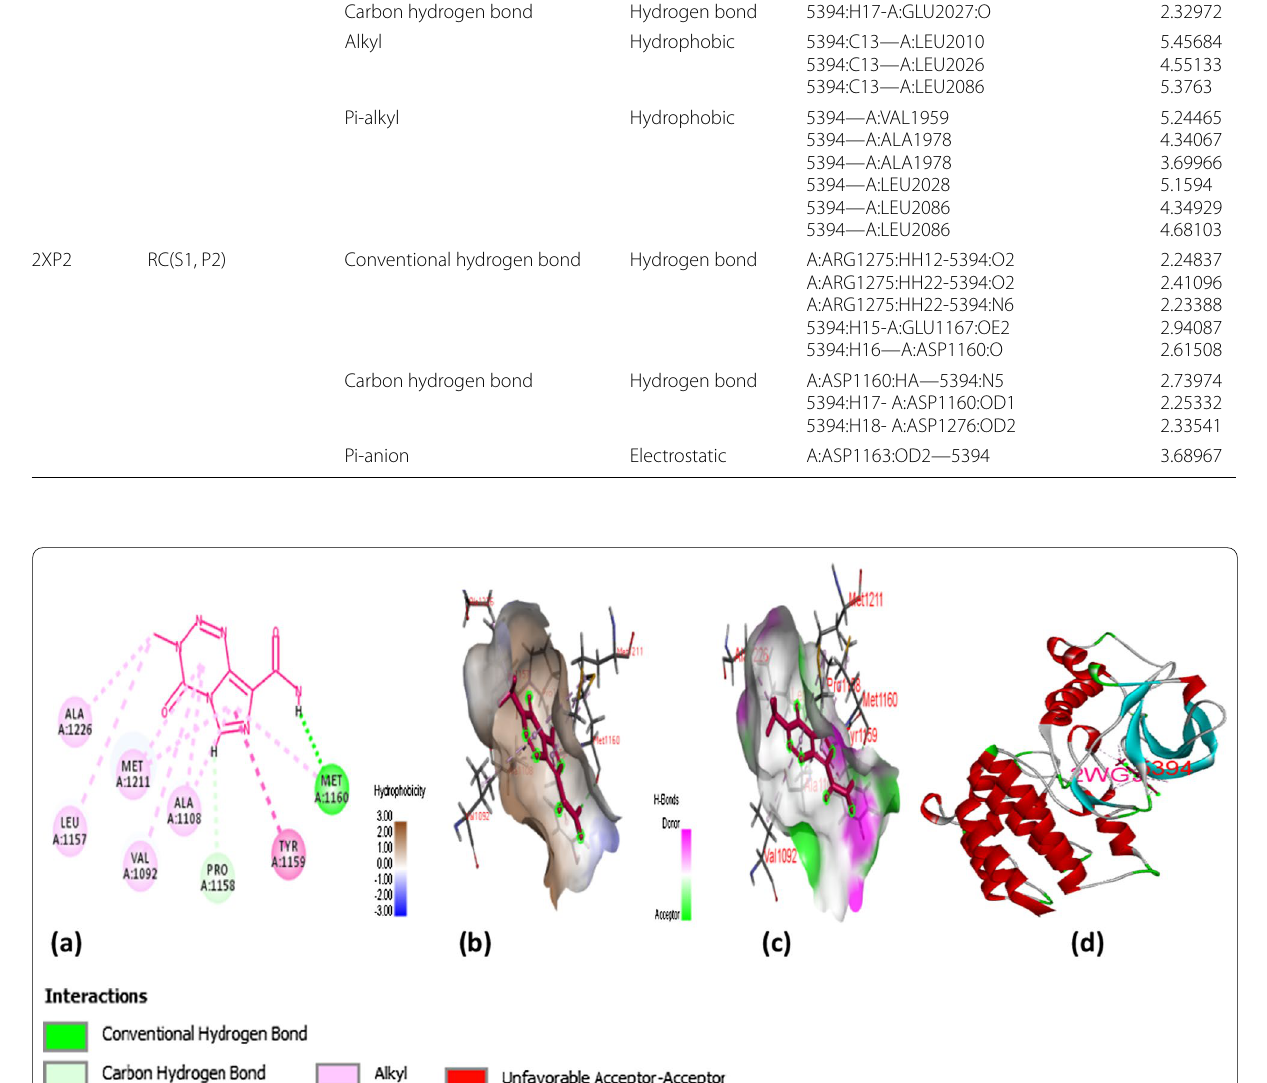
The interacting amino acid in the binding site with Temozolomide drug